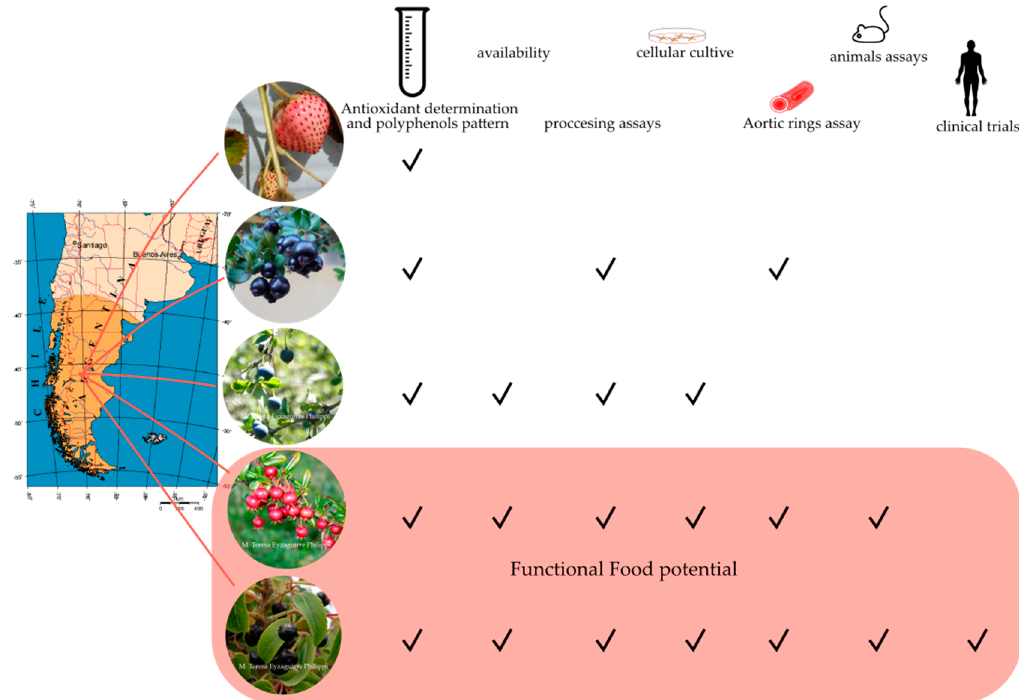
Figure 3. Summary of the Patagonian berries path to becoming functional foods. Maqui* is the native berry of Chile with major research progress concerning processing and the effect on chronic diseases. Murta* is the second most studied native berry, and two domesticated varieties are available in the market. Future studies are critical to strengthening the potential of arrayán**, calafate*, and Chilean strawberry** fruits. More details in the text. Photography credit to M. Teresa Eyzaguirre-Philippi (*) and Carlos R. Figueroa (**), map figure credit to commons.wikimedia.org/wiki/File:Pat_map.PNG, tube figure credit to https://thenounproject.com/term/test-tube/5544/, mouse figure credit to https://www.svgrepo.com/svg/53826/mouse, human figure credit to https://www.flaticon.com/free-icon/standing-human-body-silhouette_30473.